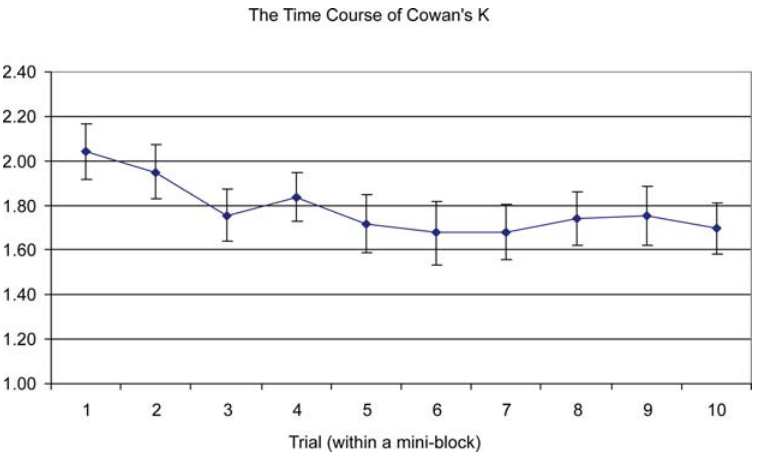
Figure 5. The decline in estimated WM capacity in terms of Cowan ’ s K (with standard errors) as a function of trial number within the ‘‘mini-blocks’’ of Experiment 2a and the blocked condition of Experiment 2b. N=41.